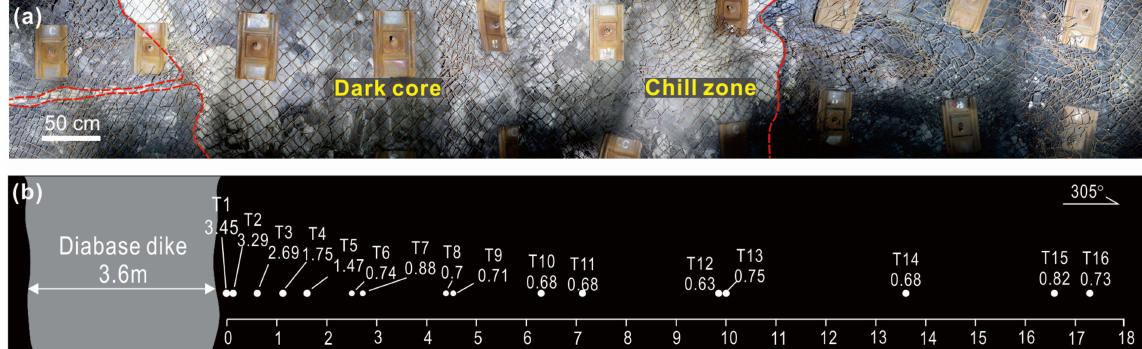
Figure 3. The sampling scheme applied in the Tashan Coal Mine: ( a ) photograph of the dike in the 8222 tunnel from Song et al. [53], modified; ( b ) samples and vitrinite maximum reflectance